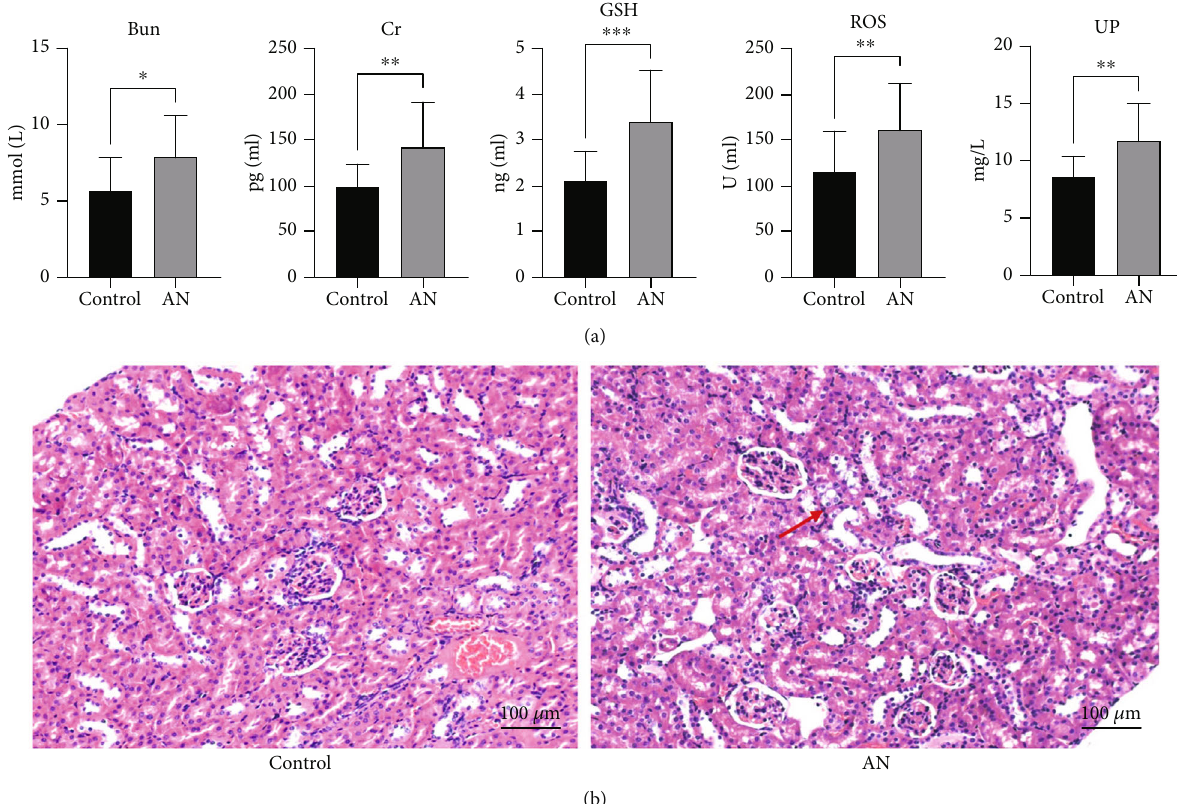
Figure 1: Kidney injury mouse model constructed by adriamycin. (a) The levels of reactive oxygen species (ROS), creatinine (Cr), glutathione (GSH), urine protein (UP), and blood urea nitrogen (BUN) were detected by enzyme-linked immunosorbent assay in adriamycin-induced nephropathy (AN) and control groups ( ∗ P < 0 : 05, ∗∗ P < 0 : 01, and ∗∗∗ P < 0 : 001 ). (b) Hematoxylin-eosin staining of mouse kidney tissues in AN and control groups. Red arrows point to damaged